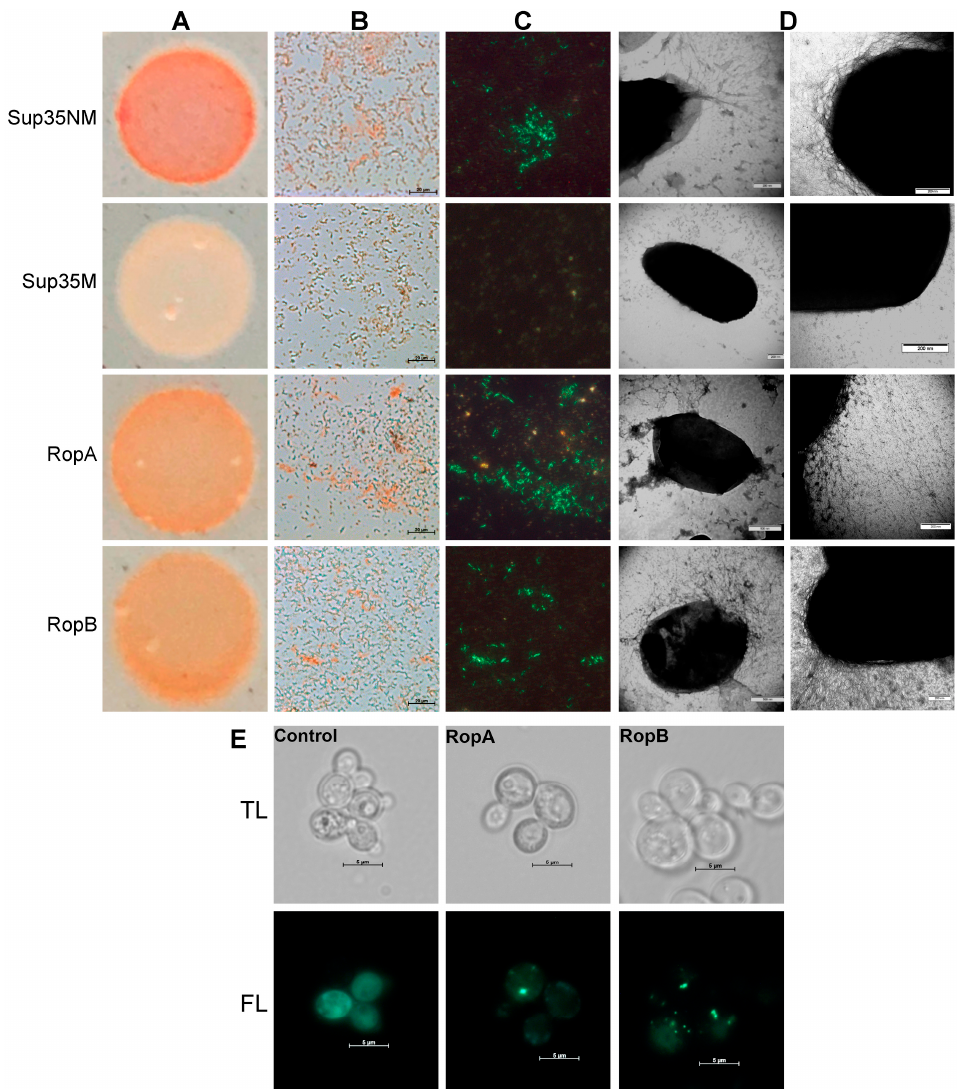
Figure 5. Analysis of the RopA and RopB amyloid properties in the Escherichia coli and Saccharomyces cerevisiae cells. ( A – D ) RopA and RopB extracellular secretion in the E. coli curli-dependent amyloid generator (C-DAG) system. ( A ) Bacterial colonies on the media containing CR. ( B ) CR-stained bacterial cells in transmitted and ( C ) polarized light. Scale bar is equal to 20 µm. The E. coli cells secreting Sup35NM (amyloid) and Sup35M (soluble) protein fragments were used as the positive and negative controls, respectively. ( D ) TEM images of E. coli exporting target proteins. Different magnifications are shown. ( E ) Analysis of aggregation of RopA and RopB proteins fused with yellow fluorescent protein (YFP) in the cells of yeast S. cerevisiae ; TL—transmitted light, FL—fluorescent light. The YFP protein was used as a negative control. Scale bar is equal to 5 µm.